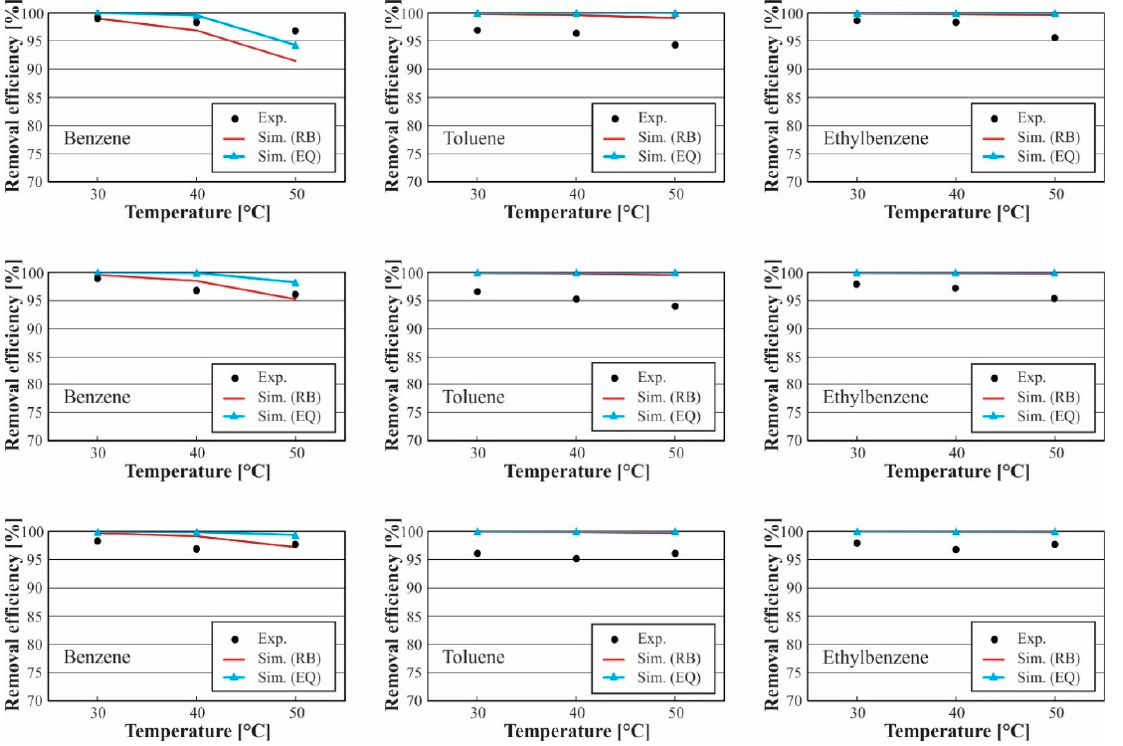
Figure 9. Effect of solvent temperature on the removal efficiency of tar components at a bed height of Figure 9. E ff ect of solvent temperature on the removal e ffi ciency of tar components at a bed height 1.1 m and different solvent volumetric flow rates of 53 mL/min (above), 63 mL/min (middle), 73 of 1.1 m and di ff erent solvent volumetric flow rates of 53 mL / min ( above ), 63 mL / min ( middle ), mL/min (below). 73 mL / min ( below